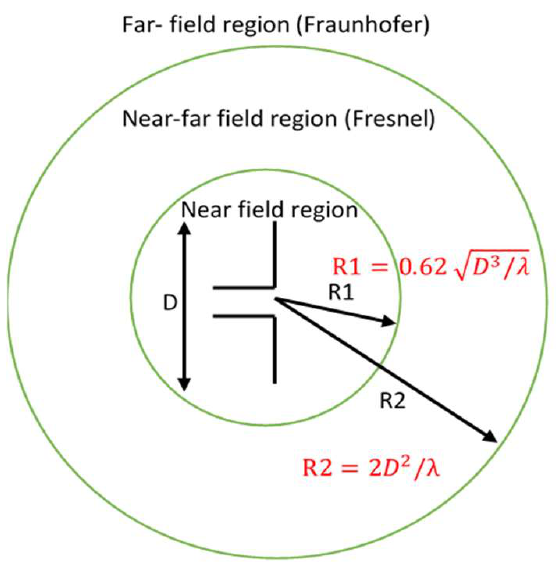
Figure 1. Three field regions for any radiated element.